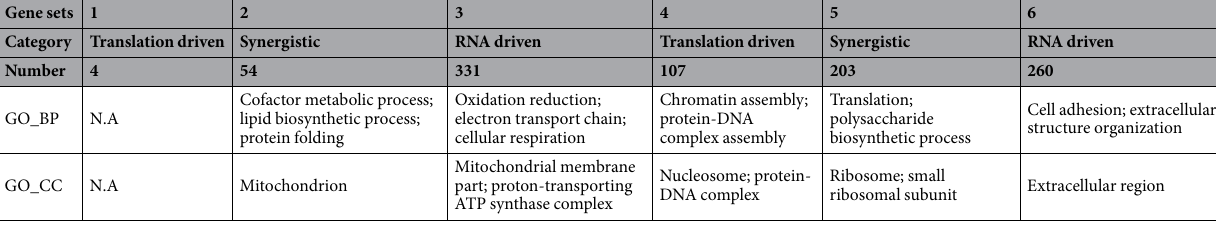
Table 1. classification of genes with regulated total translation during brown adipogenesis and their associated GOs.